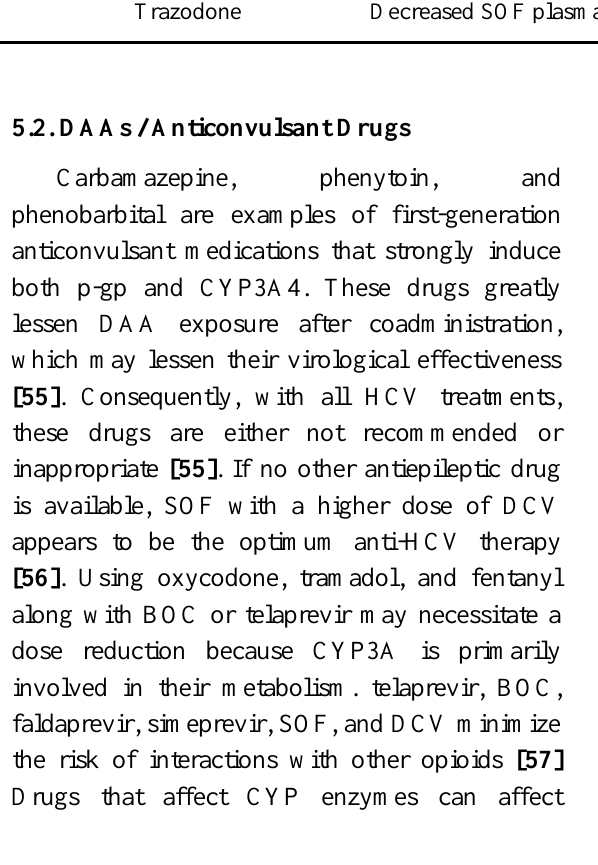
Table 1. Summary of Drug interactions between DAAs and CNS drugs DAAs CNS Drug Drug-Drug Interaction Results BOC Midazolam Raised midazolam AUC and C-max DCV CYP3A4 inducers have the potential to influence DCV plasma levels SOF SOF